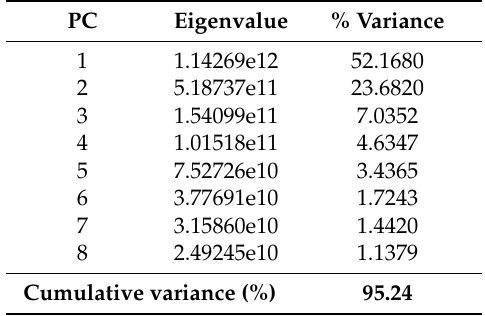
Table 1. Shape analysis of the left paramere of M. pygmaeus , M. melanotoma and M. costalis showing the eight effective principal components (PCs) with the corresponding eigenvalues and proportions of variance explained. Almost no change was observed for any reconstruction using more harmonics.